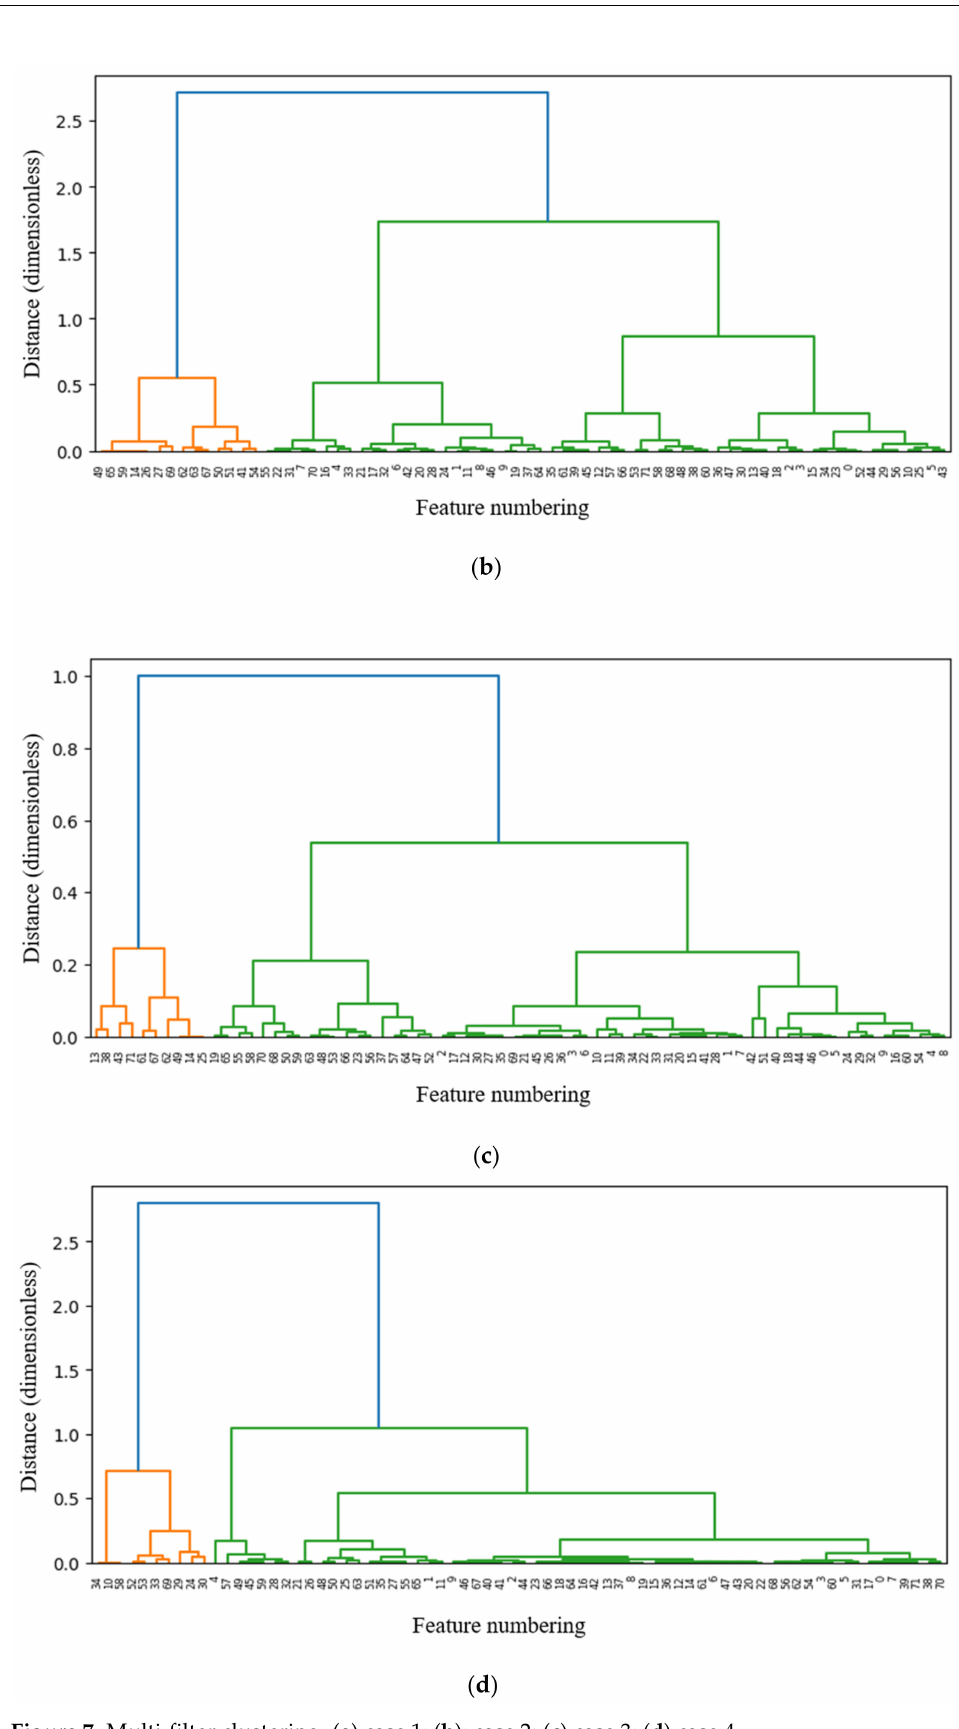
Figure 7. Multi-filter clustering. ( a ) case 1; ( b ); case 2; ( c ) case 3; ( d ) case